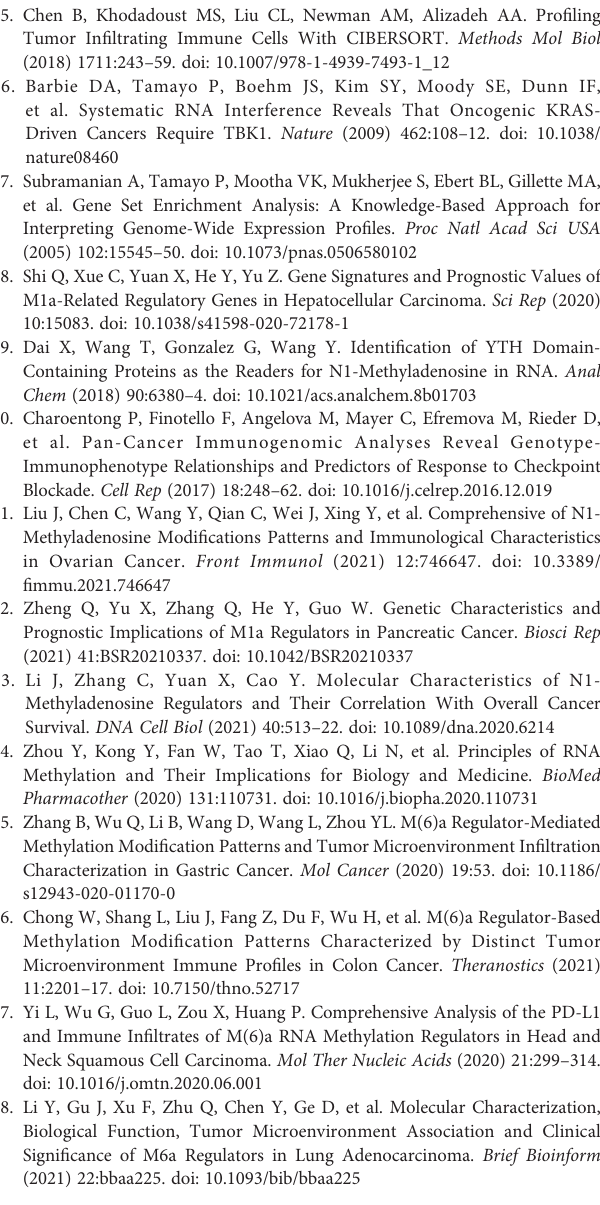
Supplementary Figure 1 | Features of genetic variations in m1A regulators in HCC. (A) Correlation between the expression of each regulator and CNVs. (B) SNV mutation of m1A regulators. Supplementary Figure 2 | GSVA of m1A-related patterns. Supplementary Figure 3 | The m1A-score model was applied to predict the prognosis of HCC patients with different clinical